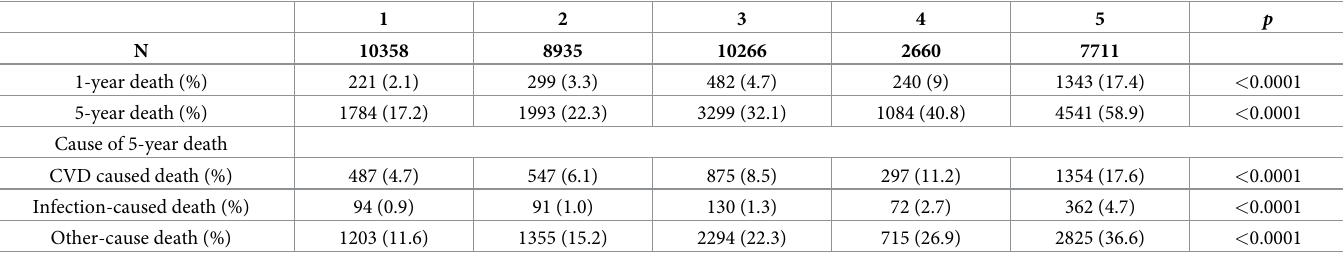
Table 5. Number of endpoints in validation